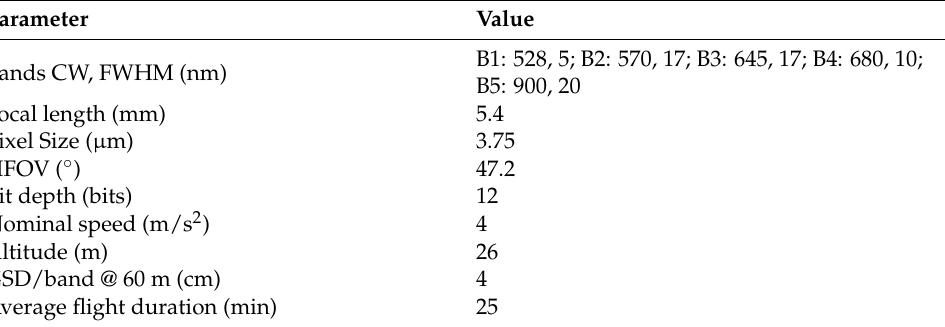
Table 2. Micasense custom-filter camera specifications and unmanned aerial vehicle (UAV) flight mission parameters used in the mission planner software PRECISIONFLIGHT v.1.4.3 (PrecisionHawk, Toronto, ON, Canada). Here, CW is centre wavelengths, FWHM is full width at half maximum, HFOV is horizontal field of view, and GSD is ground sampling